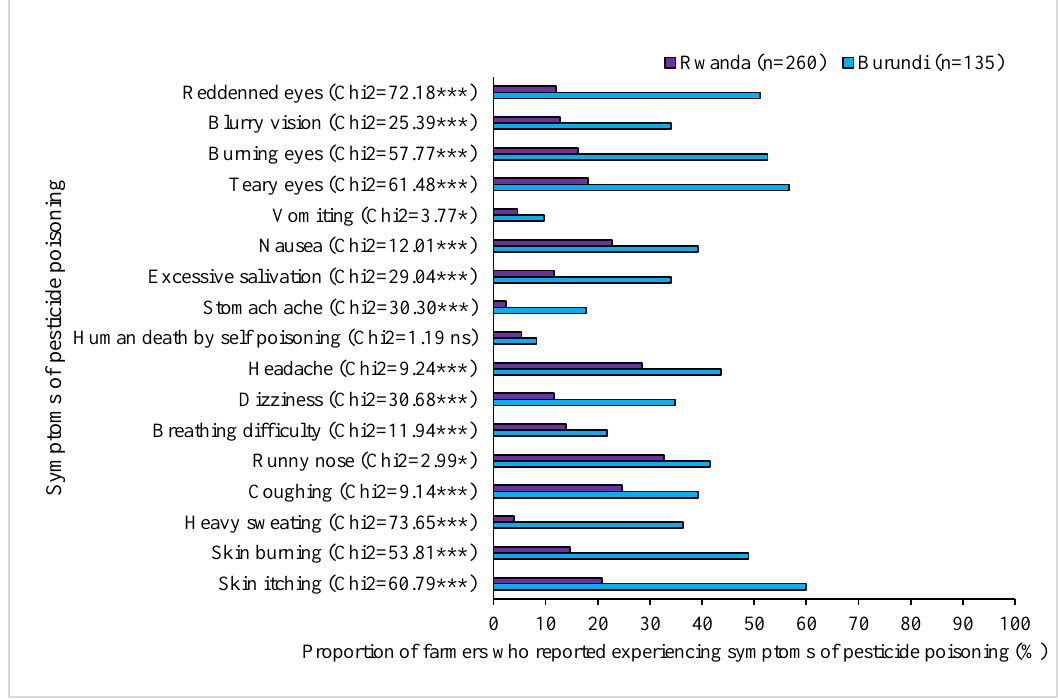
Figure 7. Symptoms after pesticide applications and consequences of pesticide poisoning reported by farmers in Rwanda and Burundi. ***, and * indicate statistical significance between the two countries at p ≤ 0.01 and p ≤ 0.1, respectively. ns: not statistically different at p ≤ 0.1).